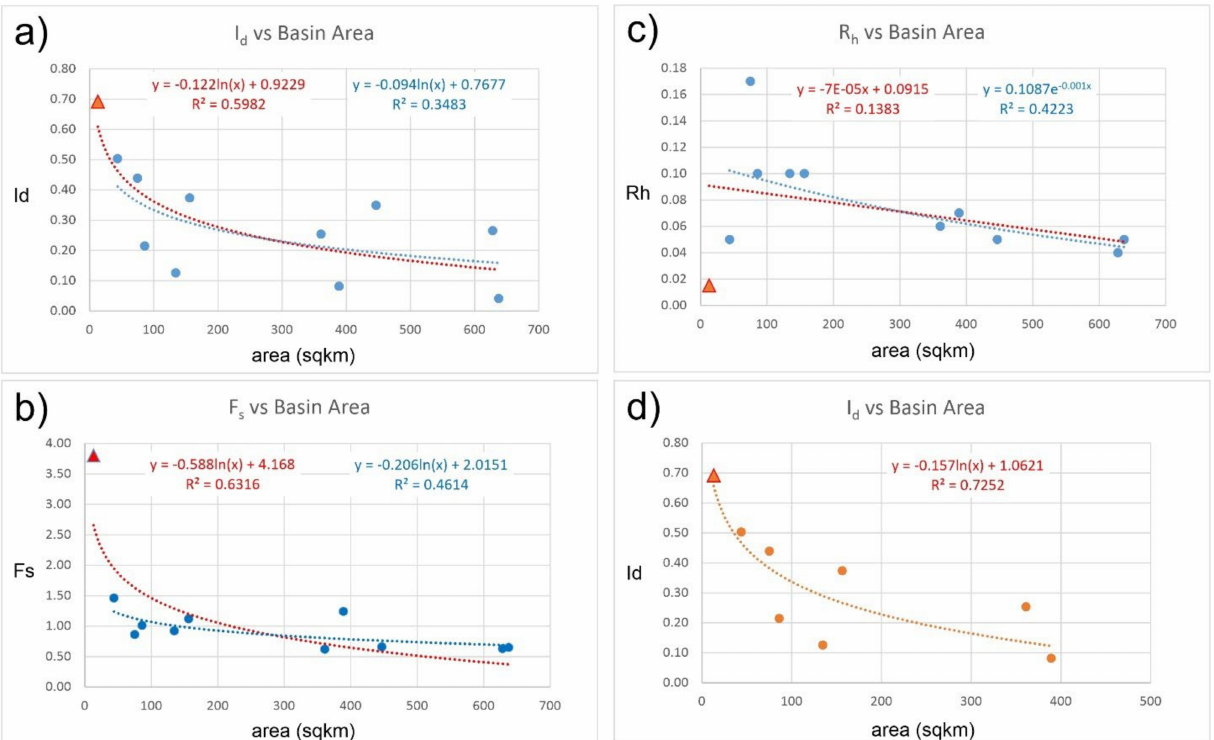
Figure 11. Relationship between some morphometric parameters and the basin area calculated on 10 artificial reservoirs and 11 contribution basins. Red and blue lines in frames ( a – c ) indicate the correlation with or without considering the San Rocco basin respectively: ( a ) Mean Annual Denudation Index (Id) vs. Area; ( b ) Stream Frequency (Fs) vs Area; ( c ) Relief Ratio (Rh) vs. Area; ( d ) Mean Annual Denudation Index (Id) vs. Area (only 8 contributing